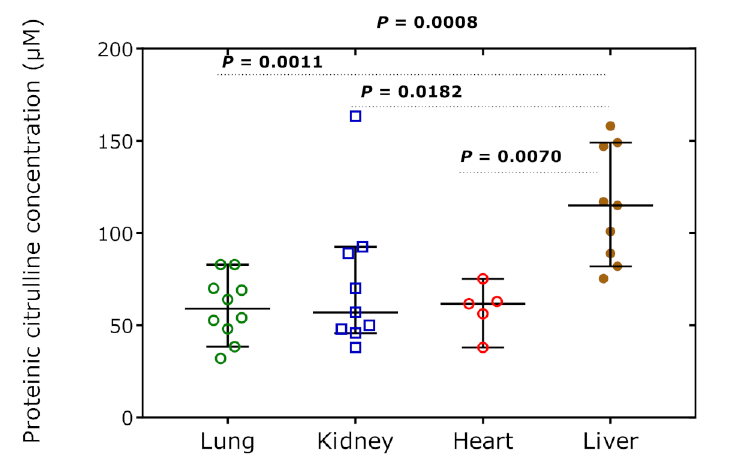
Figure 8. Concentration of Cit in the rat tissue organs over all time points. Data are shown as the median with 95% confidence interval ( n = 5–10). One-way ANOVA with Tukey’s multiple comparisons test was